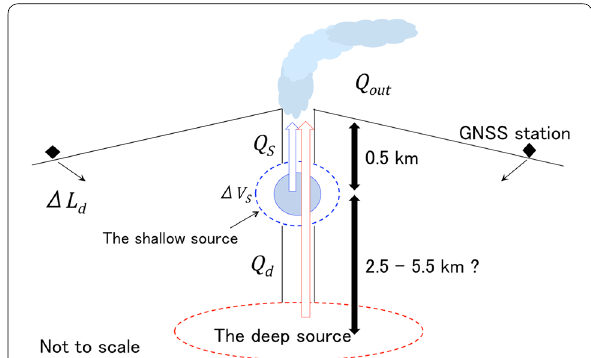
Fig. 7 Schematic illustration of mass balance between the two deflation sources and the discharged plume. Q s , Q d and Q out correspond to extruded fluid from the shallow source, the deep sources and the discharged plume, respectively. Δ V S is deflated volume of the shallow source. Δ L d indicates baseline contraction due to the deep deflation. Deformation at the surface caused by deflations of deep and shallow sources brings displacements of GNSS stations and change in LOS distance toward the